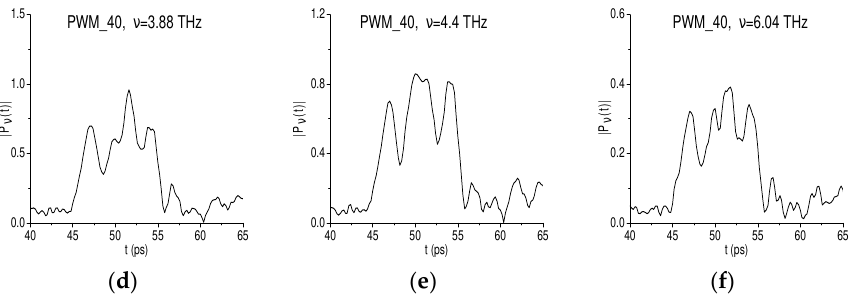
Figure 14. Time-dependent evolution of the spectral amplitude modulus of the PWM_40 signal at the frequencies ν = 1.92 THz ( a ), 2.2 ( b ), 3.0 THz ( c ), 3.88 THz ( d ), 4.4 THz ( e ), and 6.04 THz ( f ) in the time interval t = [40, 65] ps.